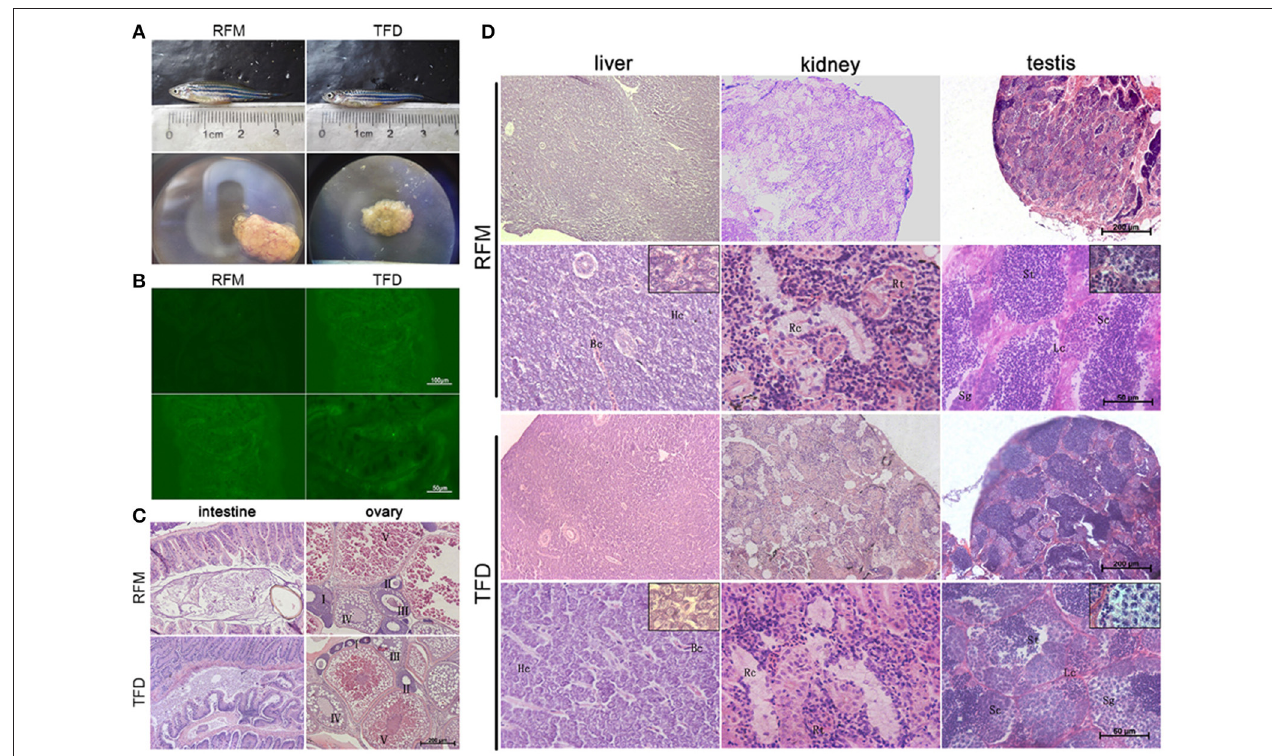
FIGURE 1 | The comparisons of different characteristics between the TFD and control RFM group. (A) The adult fish of two groups had similar body length. The gonad size of TFD fish was smaller than to the control one. (B) The intestine cells of two groups didn’t express GFP. Scale bars, 100 and 50 µ m. (C,D) Histological analyses of the intestine, liver, kidney, ovary, and testis between the TFD and RFM group. I-V mean the 5 phases of oocytes, respectively. Hc, Hepatic cell; Bc, Blood capillary; Rt, Renal tubular; Rc, Renal capsule; Sg, Spermatogonia; Sc, Spermatocyte; St, Spermatid; Lc, Leydig cell; Scale bars, 200 and 50 µ m.